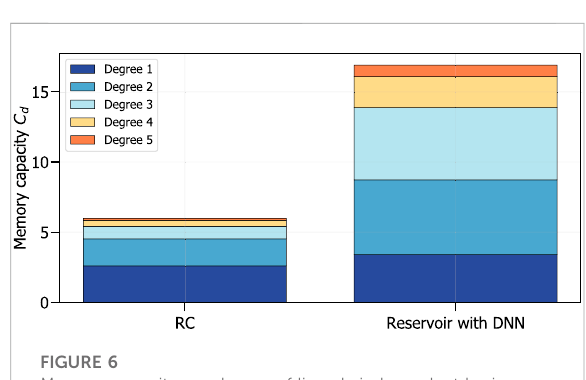
FIGURE 6 Memory capacity per degree of linearly independent basis functions for the delay-based reservoir computing system, with N =25, and the reservoir, also with N =25, coupled with the